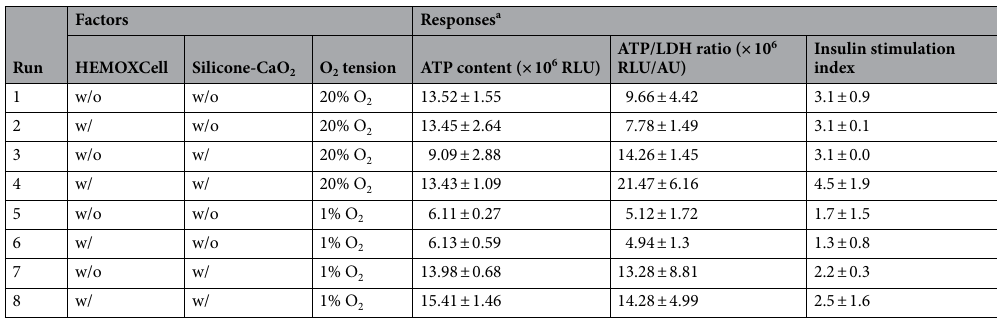
Table 1. Factorial design matrix and experimental results obtained for the screening DoE. a Mean of three independent